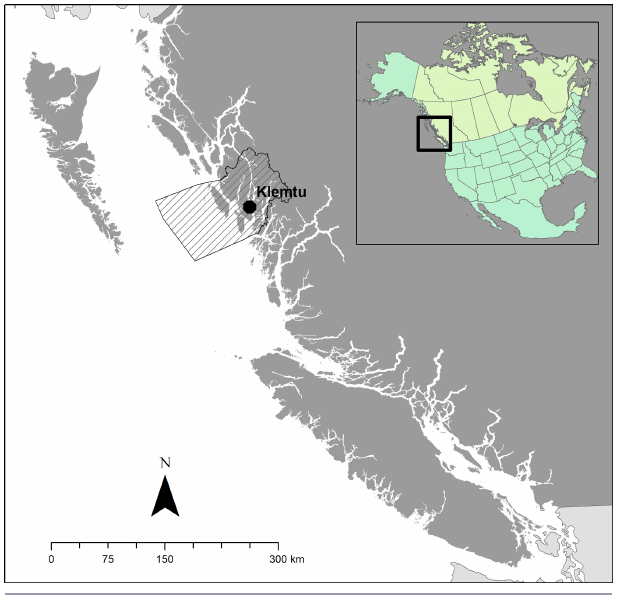
Fig. 1 . Location of the Kitasoo/Xai’xais study area. The hatched area is the territory claimed by the Kitasoo/Xai’xais